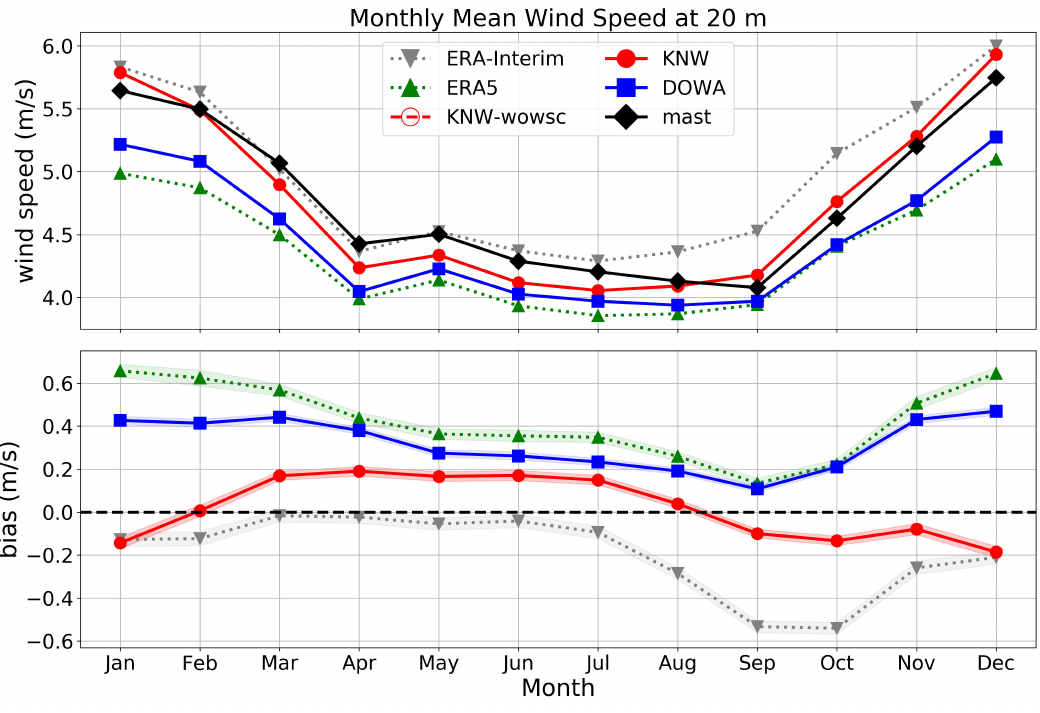
Figure 5. Monthly mean wind speed at 20 m, showing mast measurements (black), DOWA (blue), KNW atlas (red), KNW atlas without wind shear correction (red, dashed), ERA5 (green, dotted), and ERA-Interim (gray, dotted). The upper panel shows the wind speed of both mast measurements and models, the lower panel the bias (measurement minus model) between the mast measurements and the models. Model variance is indicated by the shaded areas in the lower